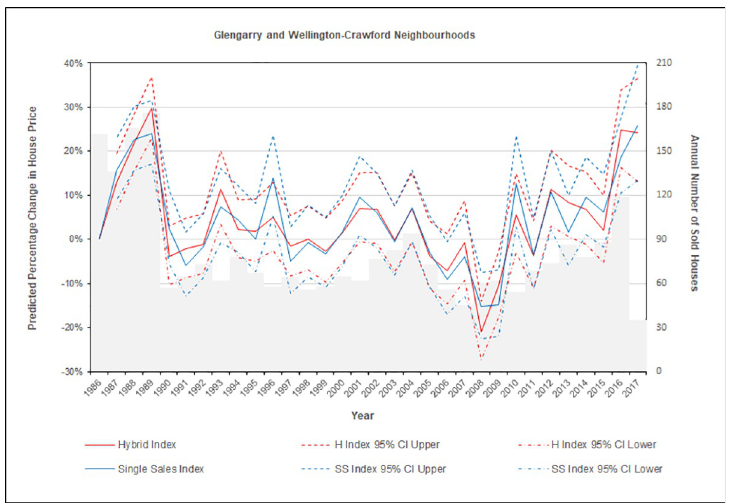
Fig 7. Predicted changes in house prices through